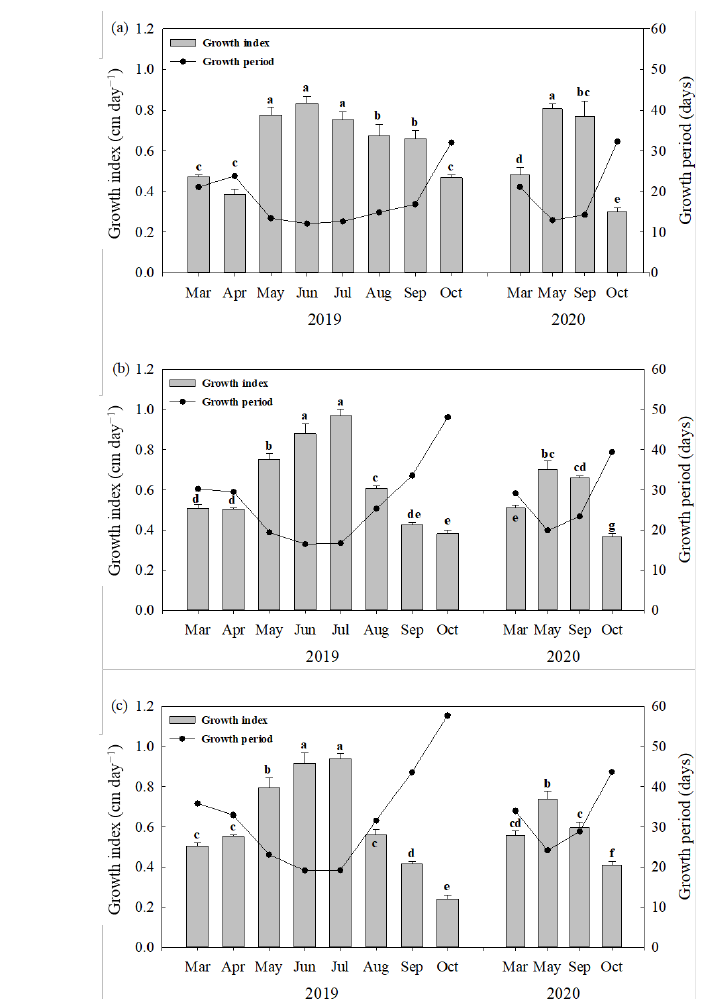
Figure 1. Growth period (GP) and growth index (GI) estimated as a ratio of leaf length to GP of 10 cm ( a ), 15 cm and ( b ), and 18 cm; ( c ) lengths of barley sprouts according to the sowing time in 2019 and 2020. Data of bar graph represent mean ± standard deviation ( n = 3) and same letters indicate no significant difference in the GI values across the two- year experiment (Tukey’s HSD, p < 0.05).